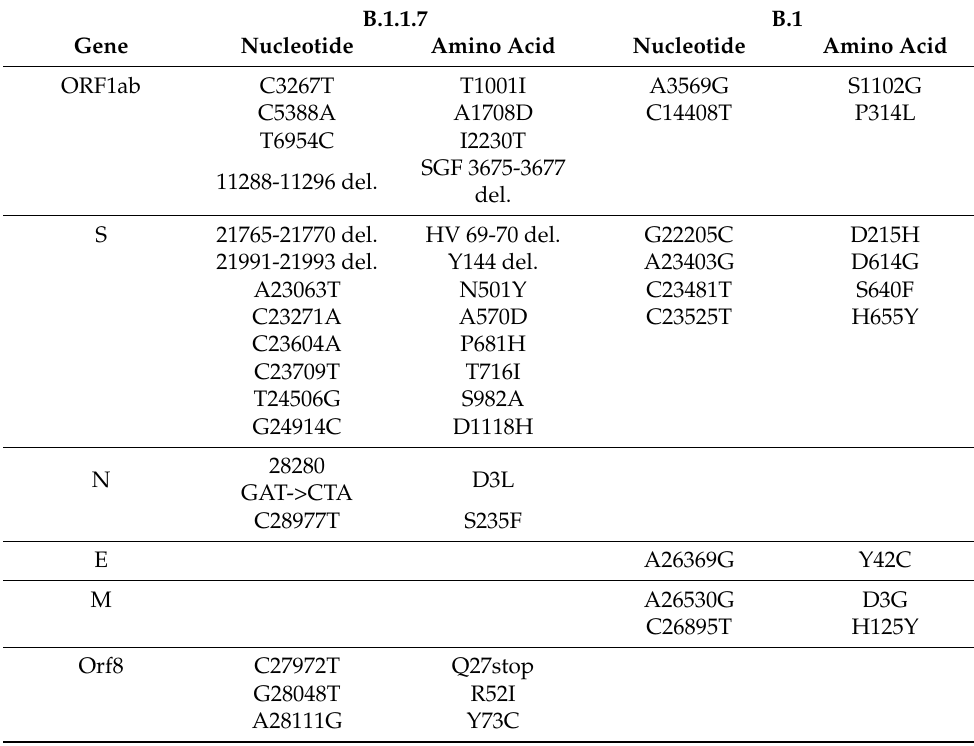
Table 2. Main mutations characterizing B.1 and B.1.1.7 lineages vs. the reference strain